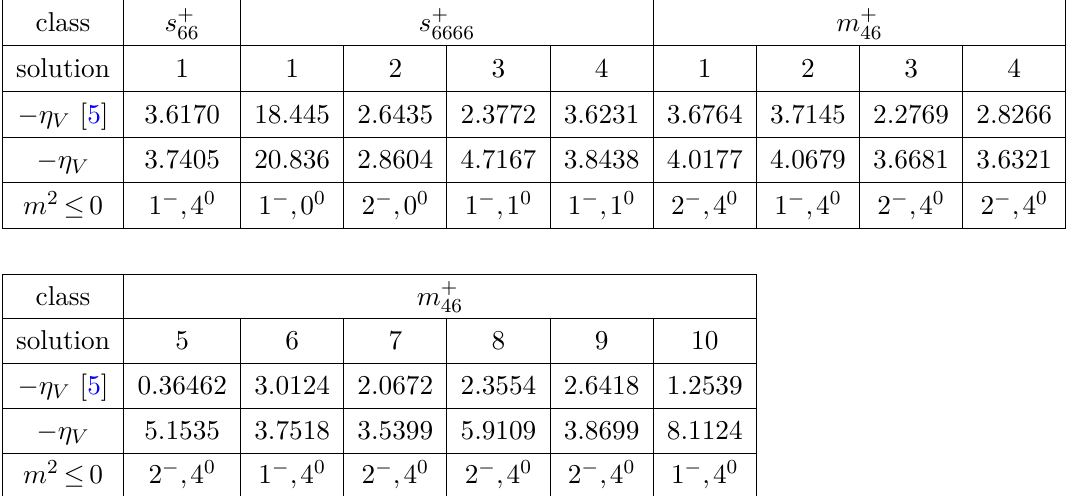
Table 5 . Spectrum information for each de Sitter solution in type IIA. We first provide the value of − η for the fields ( ρ, τ, σ ) obtained in [5], then the one obtained here with the complete set V I of scalar fields of the above dimensional reduction. By i − , j 0 , we also indicate the number j of massless modes and i of